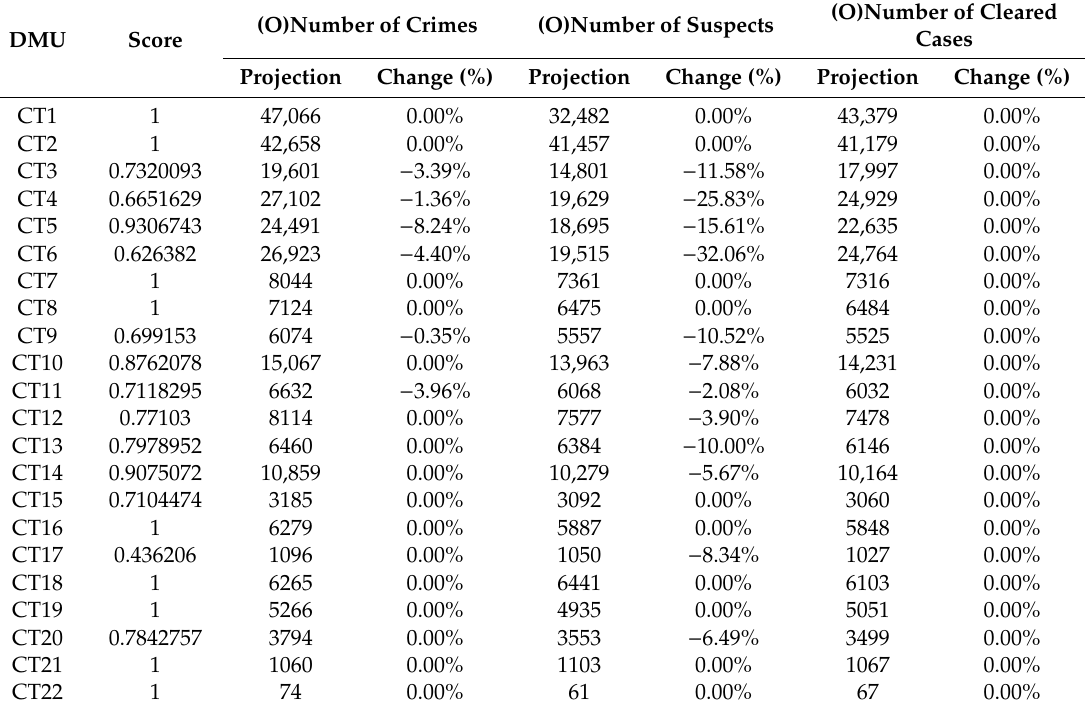
Table 8. Output factor